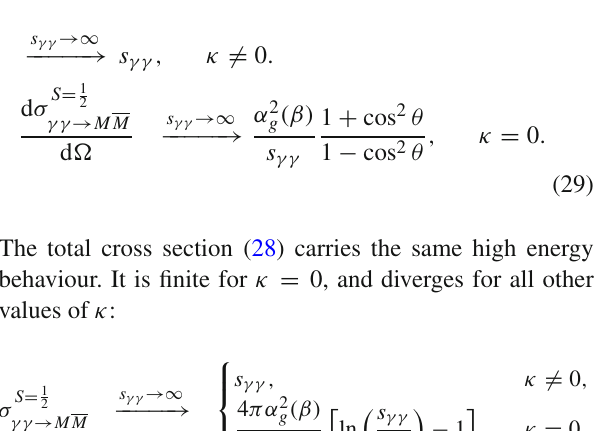
Fig. 11 Feynman-like diagram for the DY process where qq → ψψ via a virtual photon in the s -channel. The variable definitions are given in the text